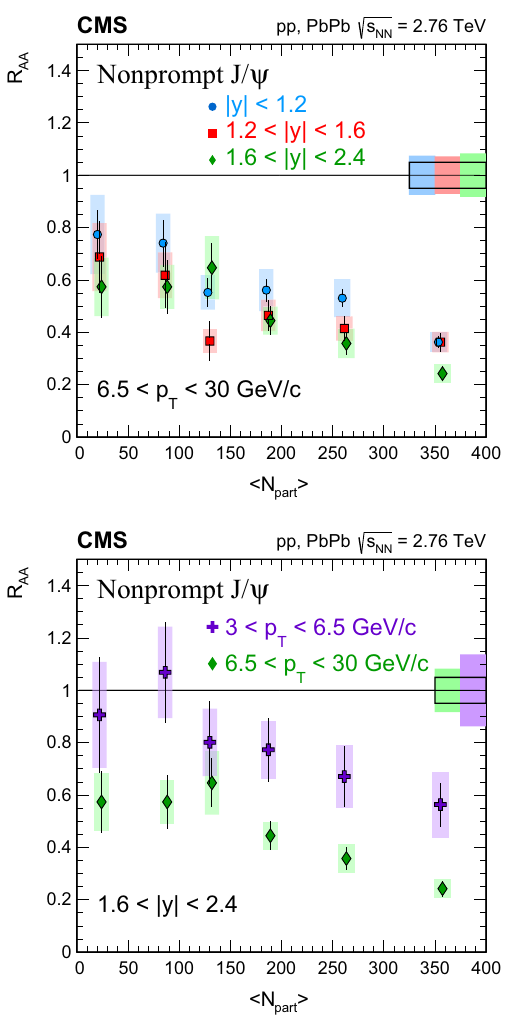
Fig. 8 Top Nonprompt J /ψ R AA as a function of centrality at high p T , 6 . 5 < p T < 30GeV / c, for three different | y | regions. The high- p T mid- and forward-rapidity points are shifted horizontally by (cid:12) N part = 2 for better visibility. Bottom Nonprompt J /ψ R AA as a function of centrality, at forward rapidity, 1 . 6 < | y | < 2 . 4, for two different p T regions. The bars ( boxes ) represent statistical (systematic) point-by- point uncertainties. The boxes plotted on the right side at R AA = 1 represent the scale of the global uncertainties: the coloured boxes show the statistical and systematic uncertainties from pp measurement, and the open box shows the global uncertainties common to all data points. The average N part values correspond to events flatly distributed across